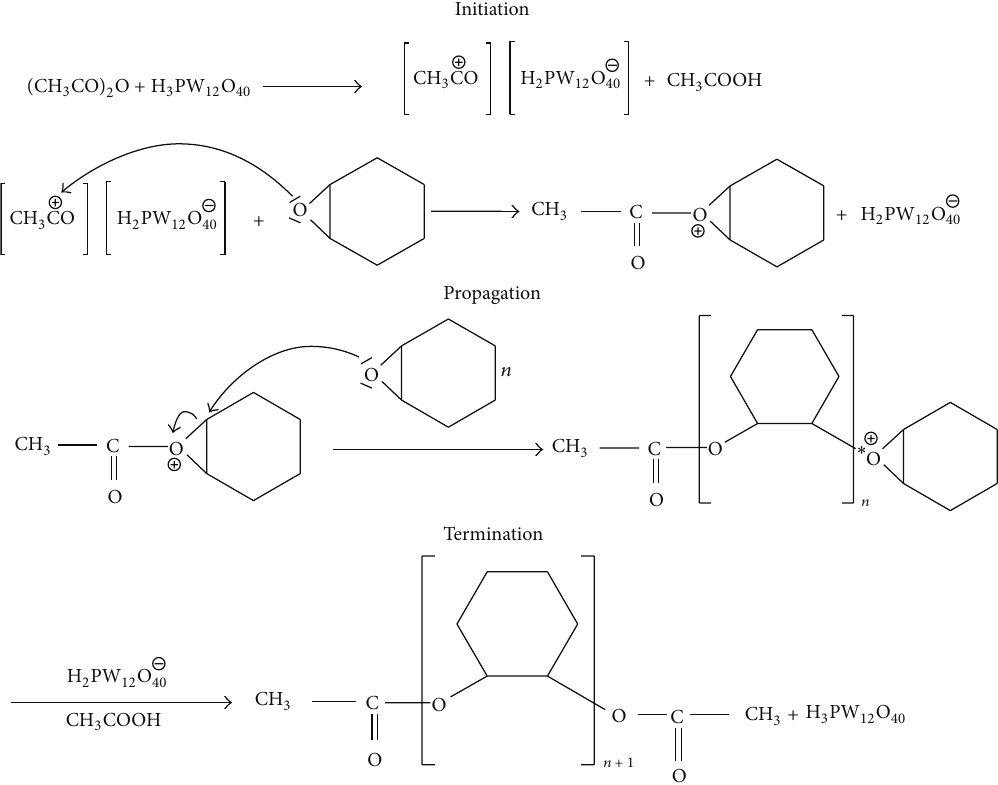
Scheme 2: Mechanism for the ring-opening polymerization of cyclohexene oxide in the presence of acetic anhydride over H 3 PW 12 O 40